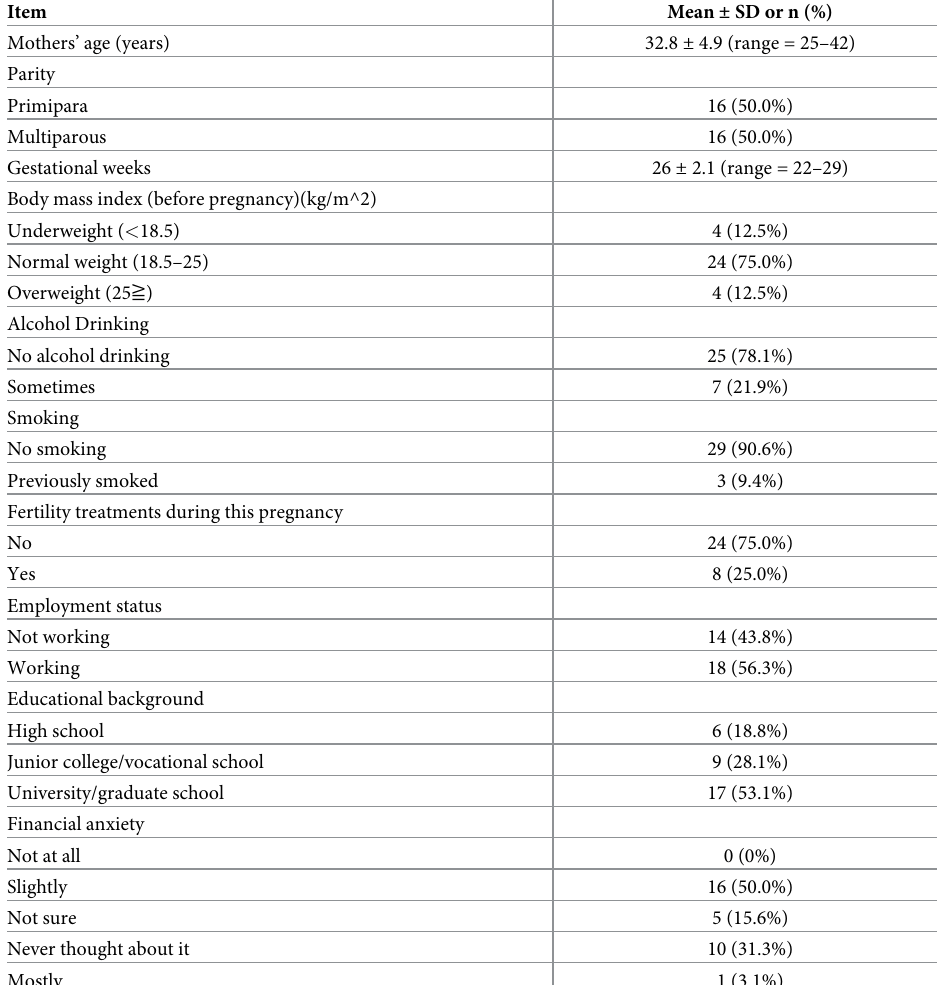
Table 1. Participants’ Characteristics. (n =